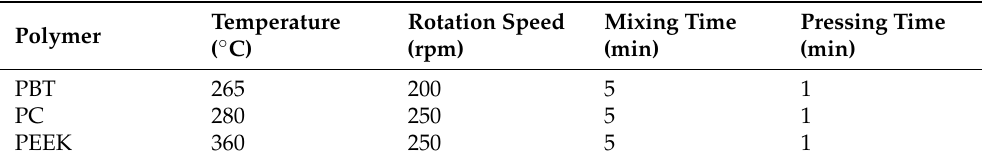
Table 1. Conditions of melt compounding and compression molding using Xplore 15 microcom- pounder and hot press